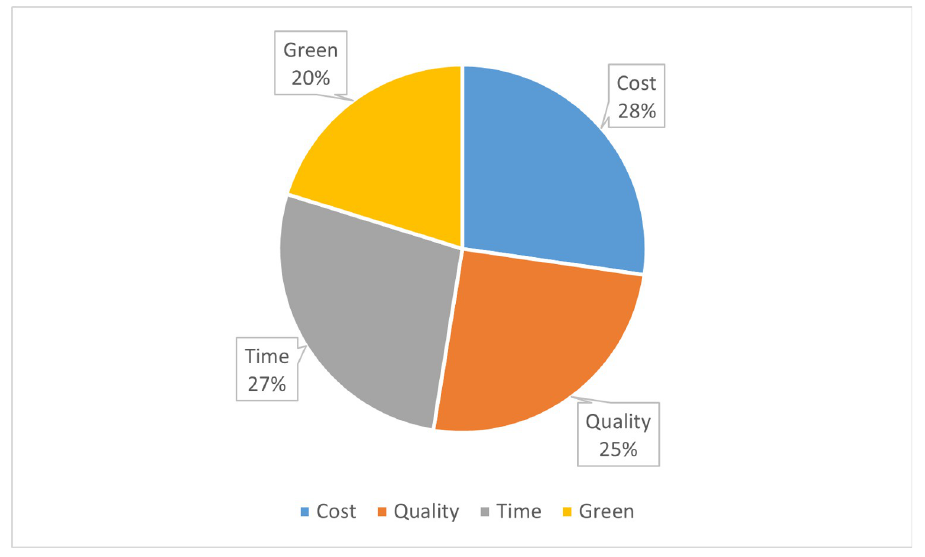
Fig 3. Contributors of the business